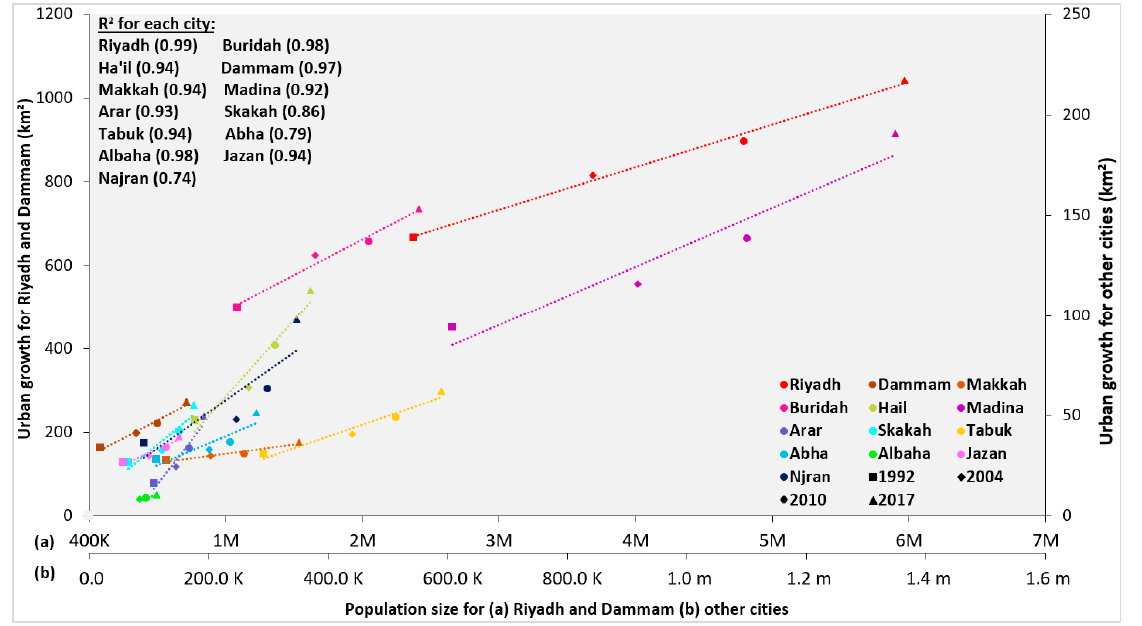
Figure 13. The trendline of urban growth and the population size.